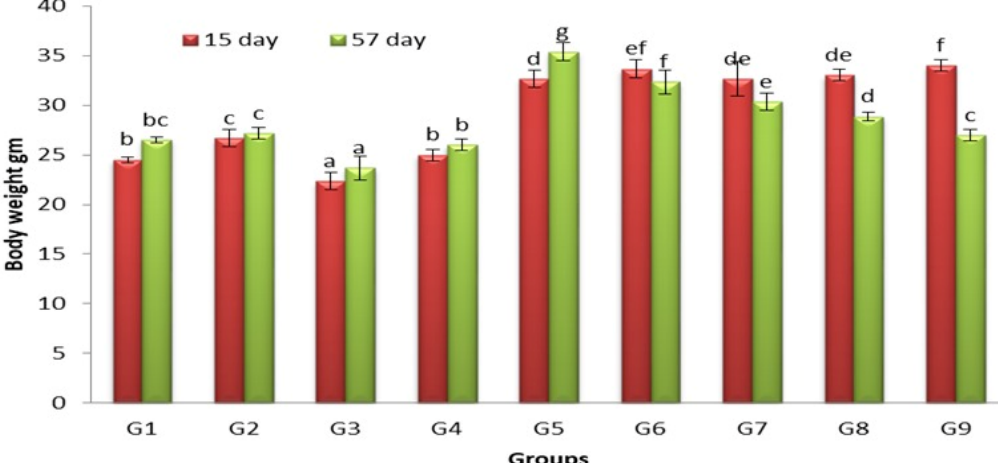
Figure 1. The influence of L. plantarum (Lp), L. casei (Lc), S. platensis (Sp) and their combination on body weight of albino mice at 15 and 57 days. Error bars represent SE of means. G1: regular diet (RD); G2: RD + Lp + Lc; G3: RD + Sp; G4: RD + Lp + Lc + Sp; G5: high-cholesterol diet (Ch); G6: Ch + Lp + Lc; G7: Ch + Sp; G8: Ch + Lp + Lc + Sp; G9: Ch+ rosuvastatin. Bars with different superscript are significantly different ( p < 0.05).